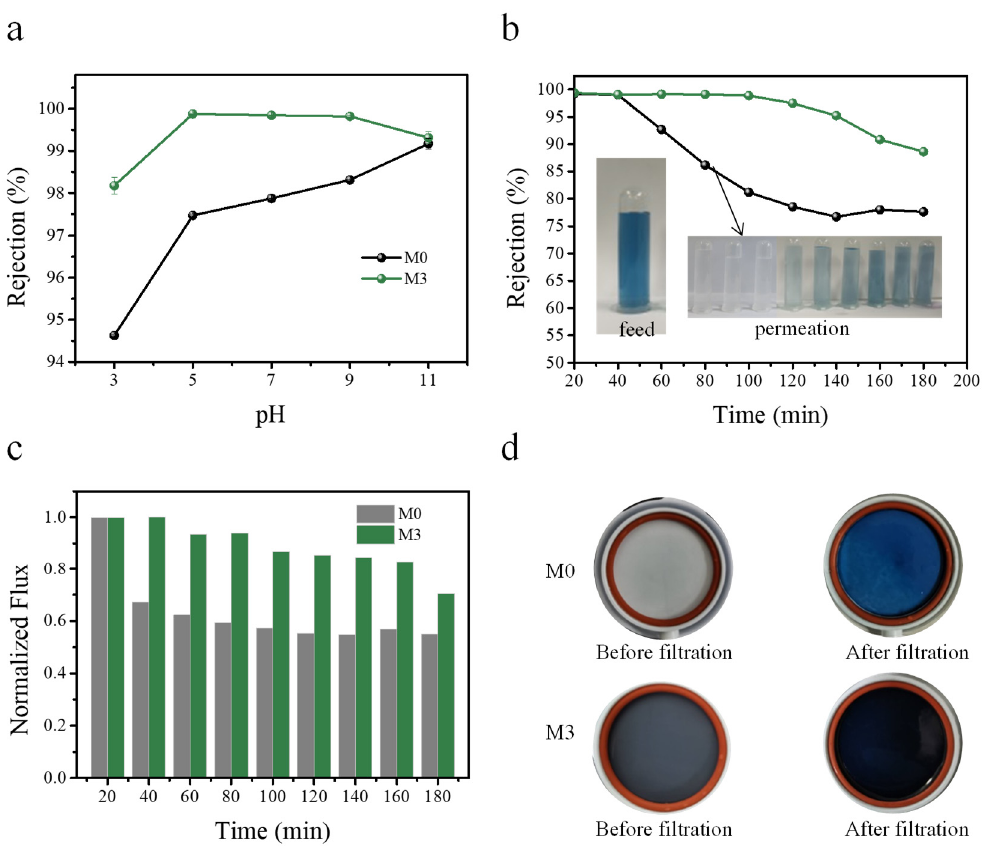
Figure 11. Separation performance of JGB dyes by membrane M0 and M3. Effect of different pH values on the membrane separation performance. (Dye: JGB, pH range: 3–11, and the pH was adjusted with HCl and NaOH) ( a ); effect of filtration time on rejection in pH 11 solution ( b ); effect of filtration time on permeation in pH 11 solution ( c ); M0 and M3 physical images before and after filtering ( d ).